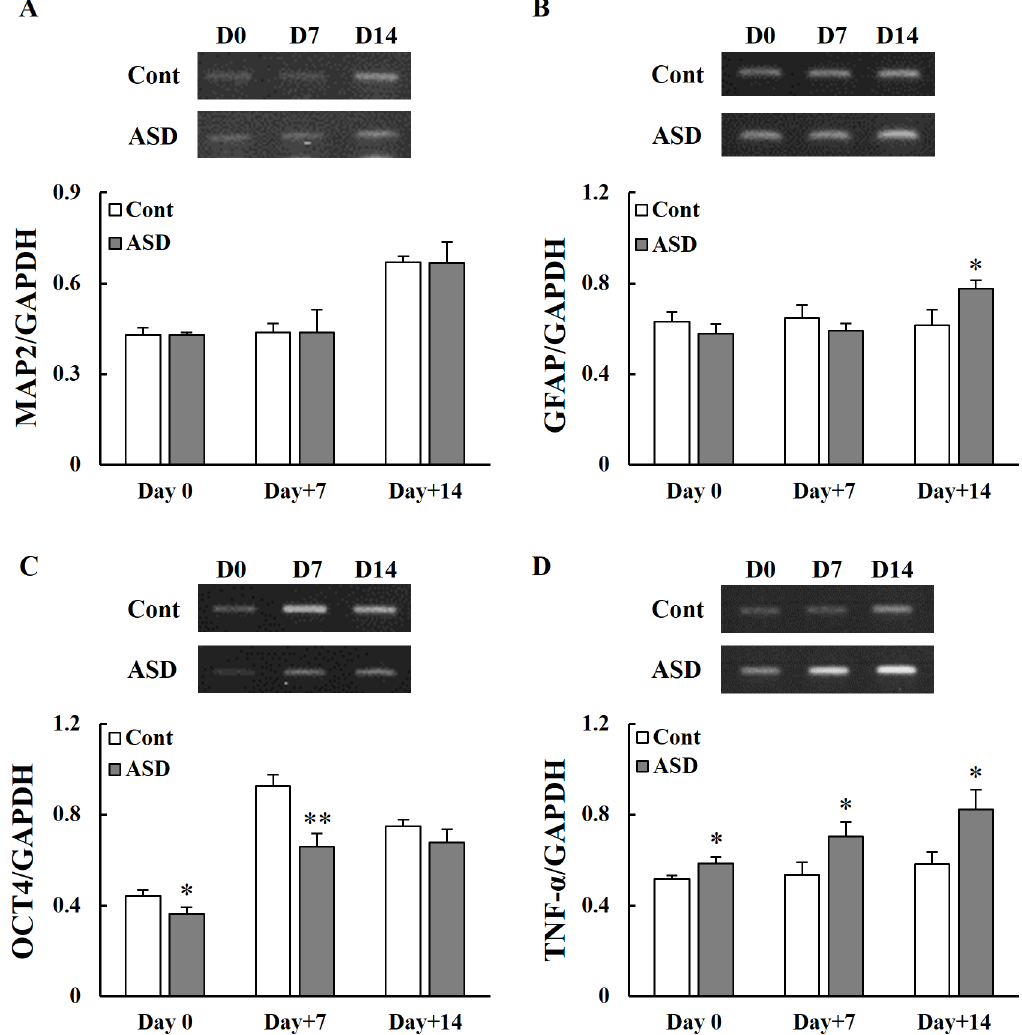
Fig 5. Changes in gene expression in the hippocampus between early and the late post- induction day following PPA administration. Gene expression of a neuron-specific microtubule associated protein ( MAP2 )(A), an astrocyte marker ( GFAP ) (B), a neural stem cell marker ( OCT4 )(C), and a pro-inflammatory cytokine ( TNF- α )(D) following PID 0 and during the late PID period (days 7 and 14). Data are shown as the mean ± SD. Cont, control rats; ASD, PPA-treated rats. (cid:3) p < 0.05, (cid:3)(cid:3) p < 0.01: vs .